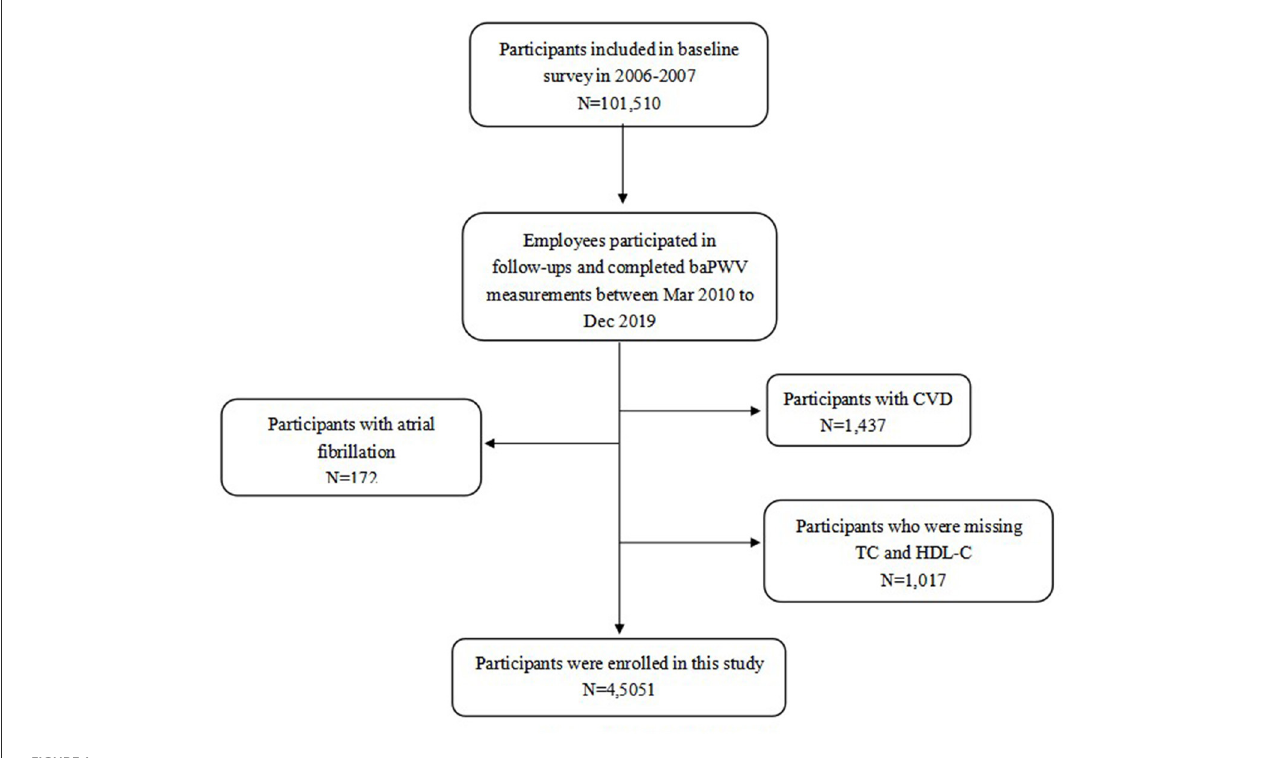
FIGURE1 Flowchart of this